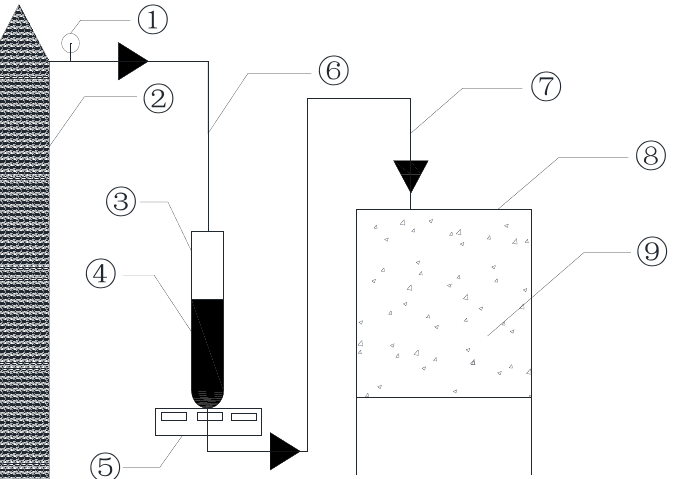
Figure 3. Schematic diagram of the grouting verification test device. ① —Nitrogen pressure reducer and grouting control switch; ② —pressure supply equipment; ③ —equipment for storing grouting slurry; ④ —Newtonian fluid slurry; ⑤ —electronic scale; ⑥ —grouting duct; ⑦ —grouting pipe; ⑧ —experimental box; ⑨ —the sand gravel.